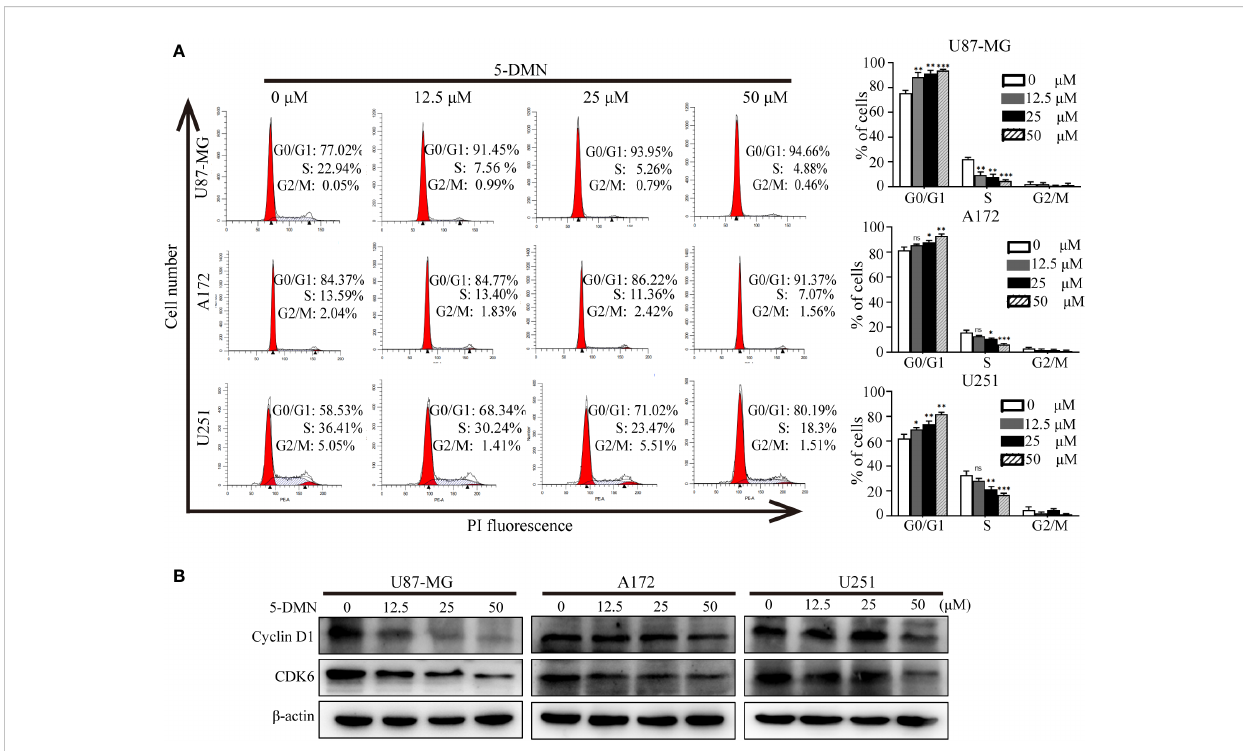
FIGURE 2 5-DMN induces cell cycle arrest at the G0/G1 phase in GBM cells. (A) The cell cycle distribution of U87-MG, A172, and U251 cells treated with different concentrations of 5-DMN was determined using fl ow cytometry. The histograms indicated the distribution of cell cycle from three separate experiments. (B) Levels of Cyclin D1 and CDK6 proteins in 5-DMN-treated GBM cells were detected by western blotting. The loading control was b -actin. *p<0.05, **p<0.01, ***p<0.001. ns, no signi fi